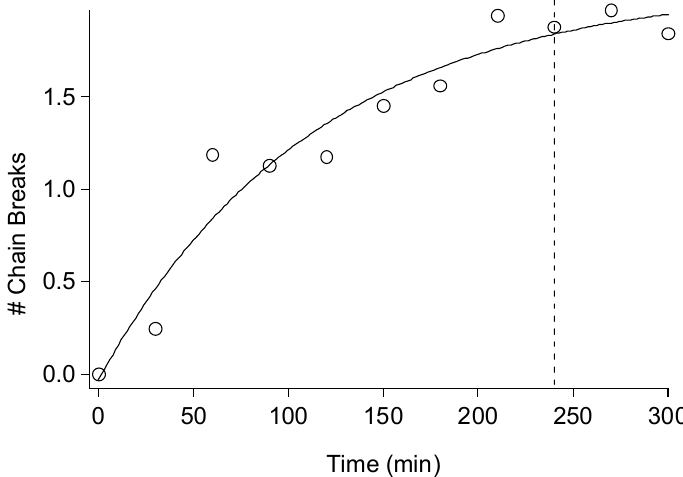
Figure 6. Number of chain breaks of cellulose from a Populus standard after holocellulose pulping and hemicellulose removal by acid hydrolysis in 2.5 M HCl at various residence ) − 1). The dotted line represents the normal 4 h times (# Chain Breaks = (DP no /DP n reaction time for hemicellulose removal typically employed and the solid line represents an exponential least-squared fit (# of chain breaks = B + A*exp(time/ τ ); B = 2.1; A = − 2.0; τ = 114.9